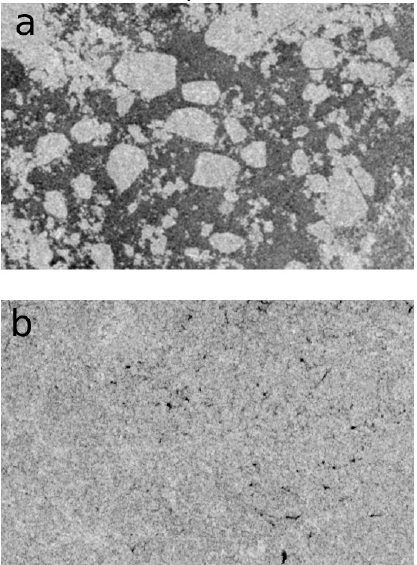
Figure 2. ( a ) Image of MIZ sea; ( b ) image of closed sea ice.